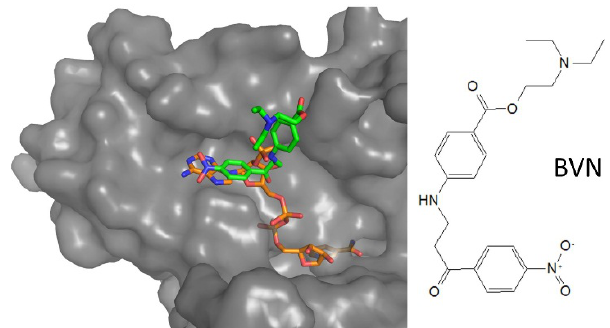
Figure 9. Mode of binding of aminoarylpropanone-derivative. Compound BVN (green) binds to NADPH (orange) binding site, where adenosine moiety locates. Protein surface is shown for BVN-bound LiTR (PDB: 6er5), superposed to NADPH-bound structure (PDB: 2w0h).